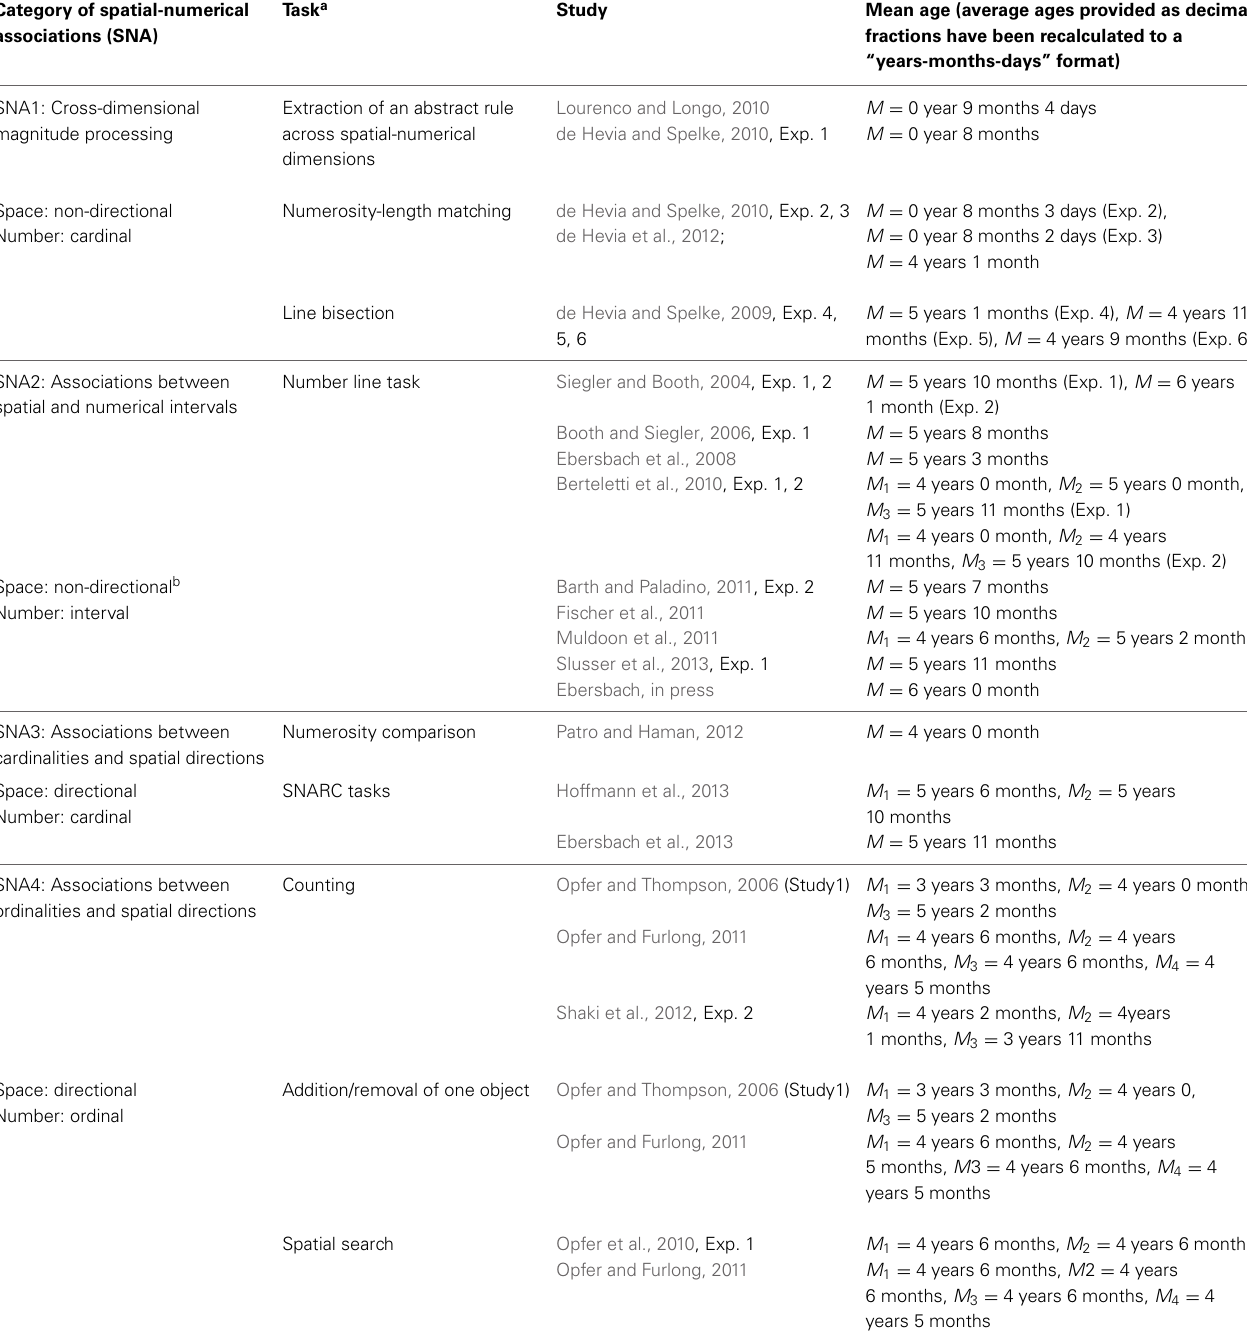
Table 1 | The four distinguished SNA categories, their measures, studies in which these measures were used, and mean age of participants. Category of spatial-numerical Task a Study Mean age (average ages provided as decimal associations (SNA)